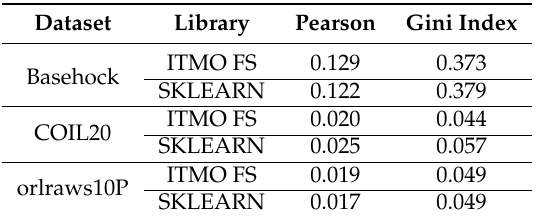
Table 2. Comparison of sklearn feature selection module and ITMO FS library computational time in